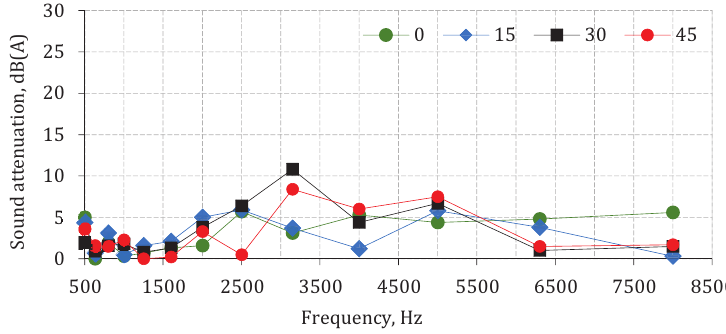
Figure 6. Test results with blades without sound any absorbing